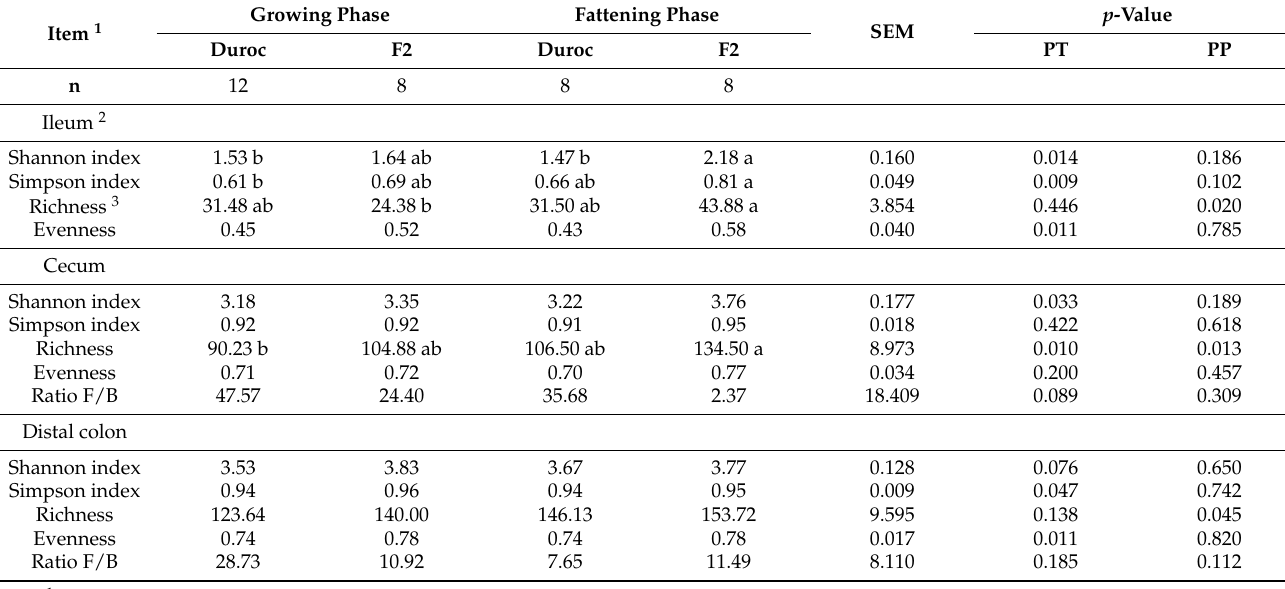
Table 2. Microbial alpha diversity indices (based on OTUs), and Firmicutes/Bacteroidetes ratio (ratio F/B) in ileum, cecum and distal colon